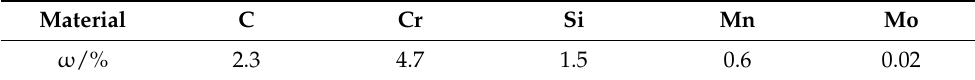
Table 1. Chemical compositions of the white cast iron.